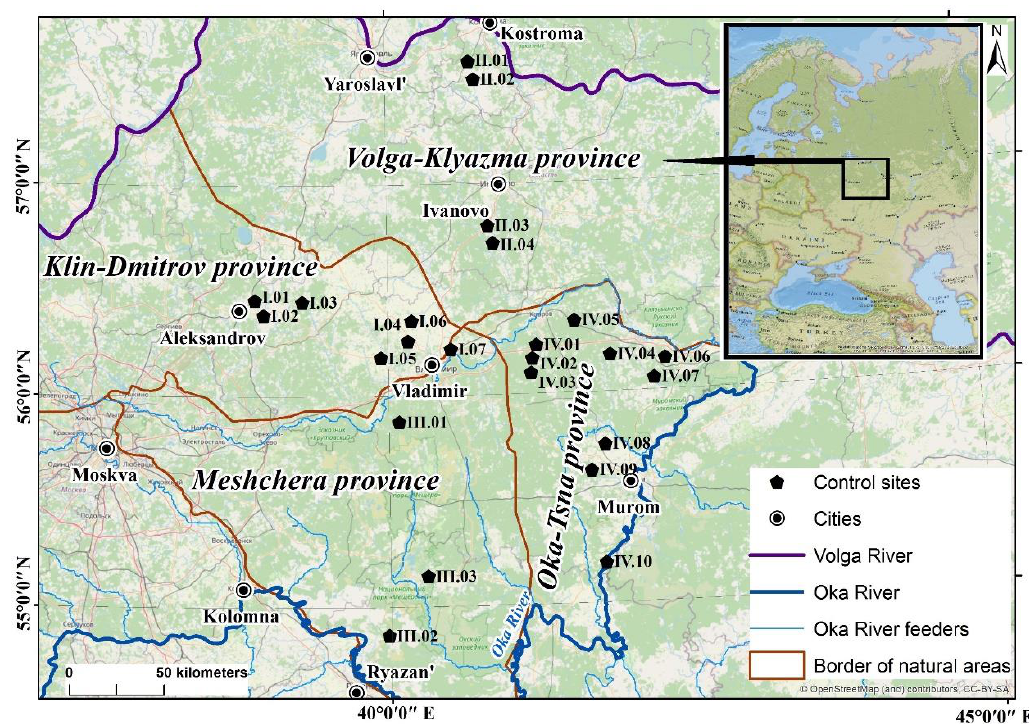
Figure 1. Location of key sites. The Open Street Map substrate (map scale of 1:1,500,000) was used as the topographic base for the raster map of key sites. Control sites are marked with a pentagon; cities are marked with a circle; the Oka River is marked with a light blue line; the Volga River is marked with a dark blue line; tributaries of the Oka River are marked with a thin light blue line; and the border of natural areas is marked with a light brown line.